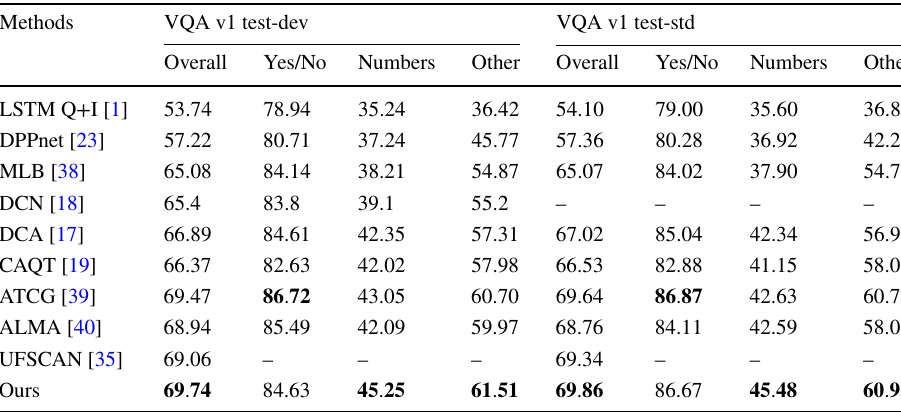
Results in Table 1 are the performance of a single model of the compared methods on the same training set. “–” indicates the result is not available. “Overall” represents the final overall accuracy. “Yes/No”, “Num”, and “Other” respectively indicate the accuracy of three different question types under the subdivision Bold value is the best among all